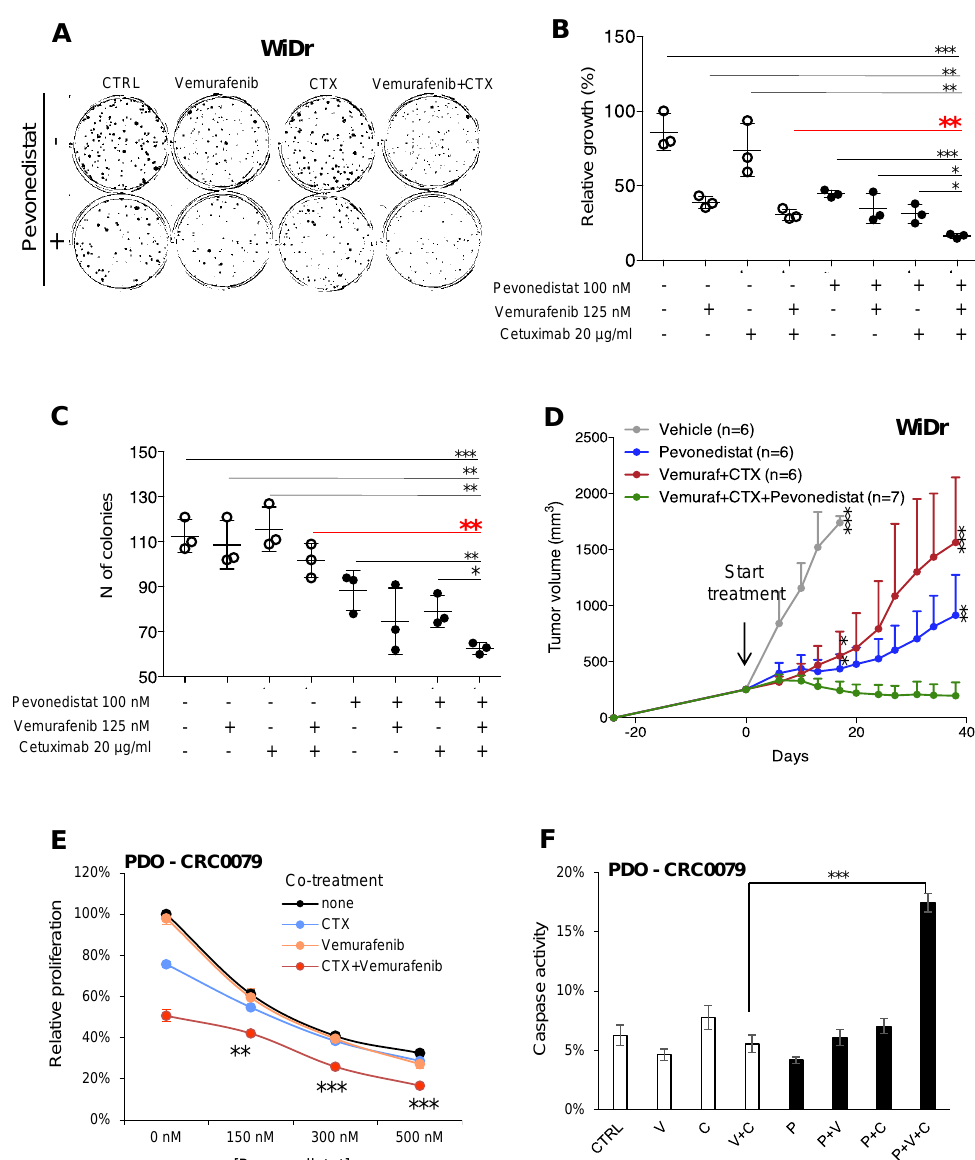
Figure 3. Pevonedistat and EGFR pathway cooperate in BRAF -mutant CRCs. ( A ) Clonogenic potential of WiDr cells was evaluated in response to pevonedistat (100 nM), cetuximab (CTX, 20 µg/mL), and vemurafenib (125 nM) alone or in combination. After 17 days, cells were fixed by crystal violet. ( B , C ) Relative growth of colonies ( B ) and their number ( C ) were quantified in triplicate. Significant differences among triple combination and other treatment groups (pevonedistat—P; vemurafenib—V; cetuximab—C) were analyzed by applying Student t test (*: p < 0.05; **: p < 0.01; ***: p < 0.001; the red color highlights comparisons between the triple treatment and the standard double treatment). ( D ) Mice transplanted with WiDr cells were randomized in four groups and treated with vehicle, pevonedistat (90 mg/kg), cetuximab (CTX—20 mg/kg), and vemurafenib (60 mg/kg) alone or in combination. Tumor volume (mean ± SD) was measured weakly. Growth curves were compared by Student t test analysis for the evaluation of significant differences among groups (***: p < 0.001; **: p < 0.01; *: p < 0.05). ( E , F ) BRAF -mutant patient-derived organoid (PDO, CRC0079) was treated for 96 h with vemurafenib (125 nM), cetuximab (CTX, 20 µ g/mL) and increasing pevonedistat concentrations (150, 300, 500 nM). Data are expressed as average ± SD of three technical replicates. ( E ) Cells proliferation was quantified by Cell Titer Glo assay, and significant differences among groups were calculated by applying Student t test (V + C vs V + C + P: **: p < 0.01; ***: p < 0.001). ( F ) Caspase-3/7 activity was quantified by Caspase Glo Assay after 96 h treatment and expressed as ratio of proliferation. Significant differences among V + C and V + C + P groups were calculated by applying Student t test (***: p <